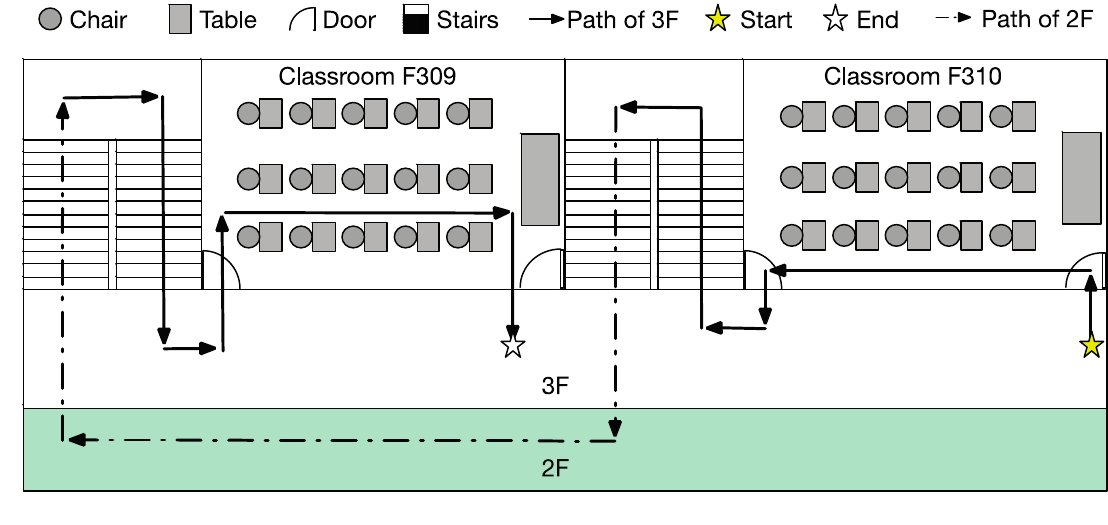
Figure 28. The experimental environment.